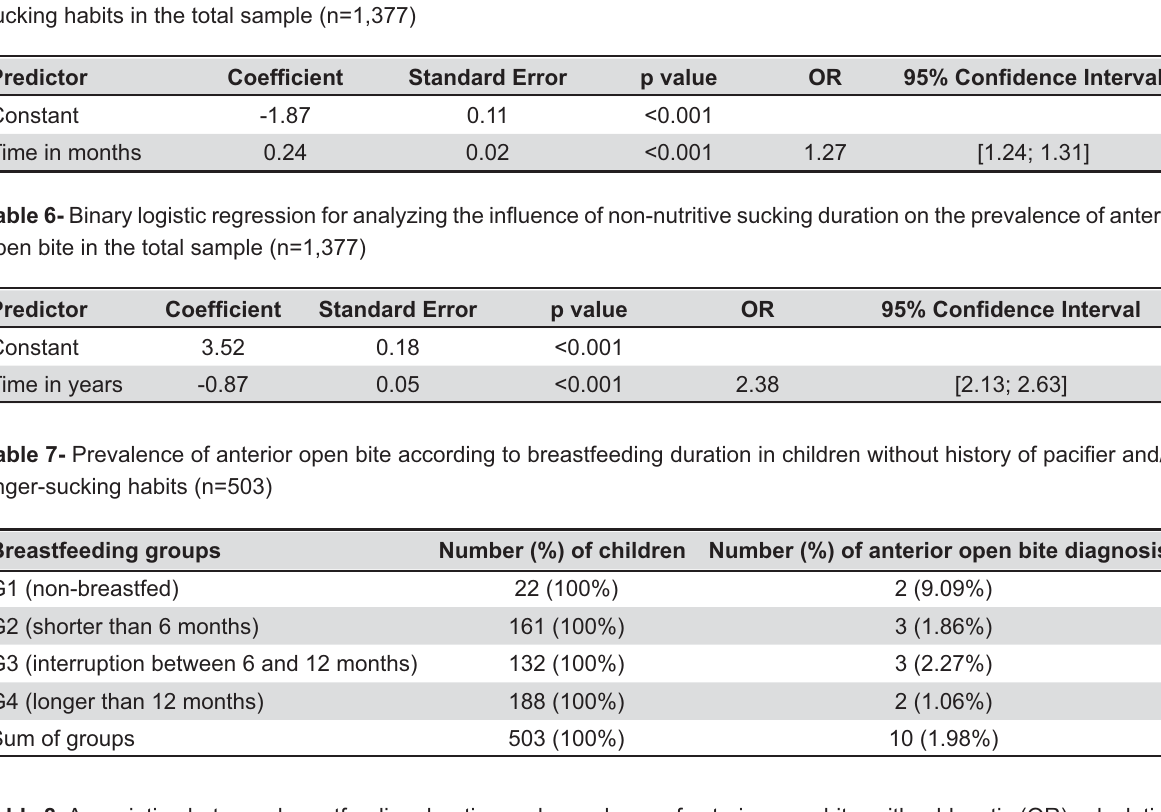
Table 8- Association between breastfeeding duration and prevalence of anterior open bite, with odds ratio (OR) calculation, (cid:4)(cid:5)(cid:2)(cid:14)(cid:18)(cid:4)(cid:9)(cid:22)(cid:7)(cid:15)(cid:5)(cid:2)(cid:28)(cid:4)(cid:13)(cid:18)(cid:10)(cid:20)(cid:13)(cid:2)(cid:18)(cid:4)(cid:12)(cid:13)(cid:10)(cid:7)(cid:8)(cid:2)(cid:10)(cid:16)(cid:2)(cid:23)(cid:6)(cid:14)(cid:4)(cid:29)(cid:15)(cid:7)(cid:2)(cid:6)(cid:5)(cid:22)(cid:30)(cid:10)(cid:7)(cid:2)(cid:29)(cid:5)(cid:11)(cid:15)(cid:7)(cid:25)(cid:12)(cid:20)(cid:14)(cid:26)(cid:4)(cid:5)(cid:11)(cid:2)(cid:18)(cid:6)(cid:21)(cid:4)(cid:13)(cid:12)(cid:2)(cid:31)(cid:5)!"#$&